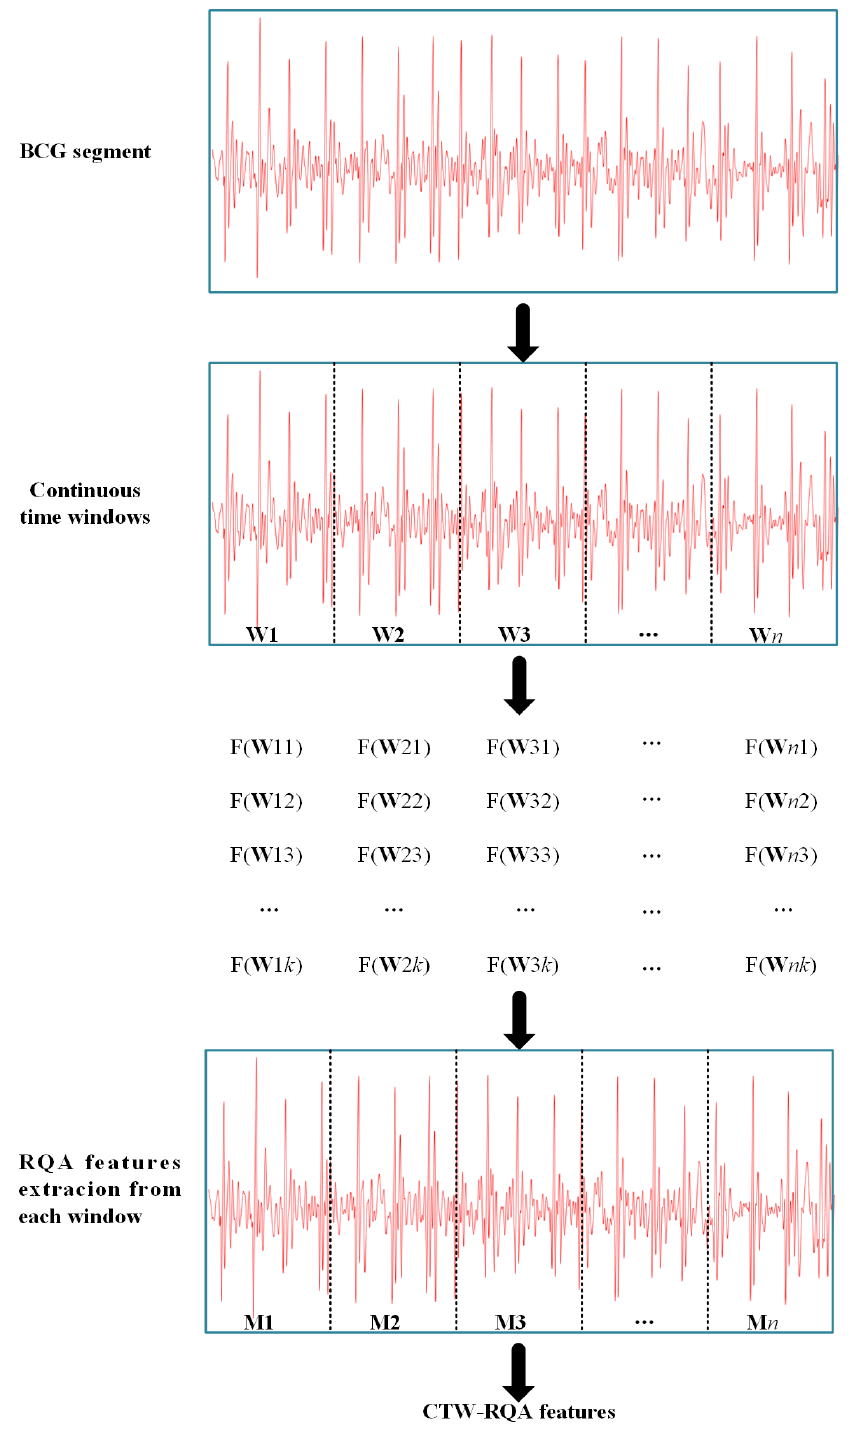
Figure 4. The process of CTW – RQA feature extraction.